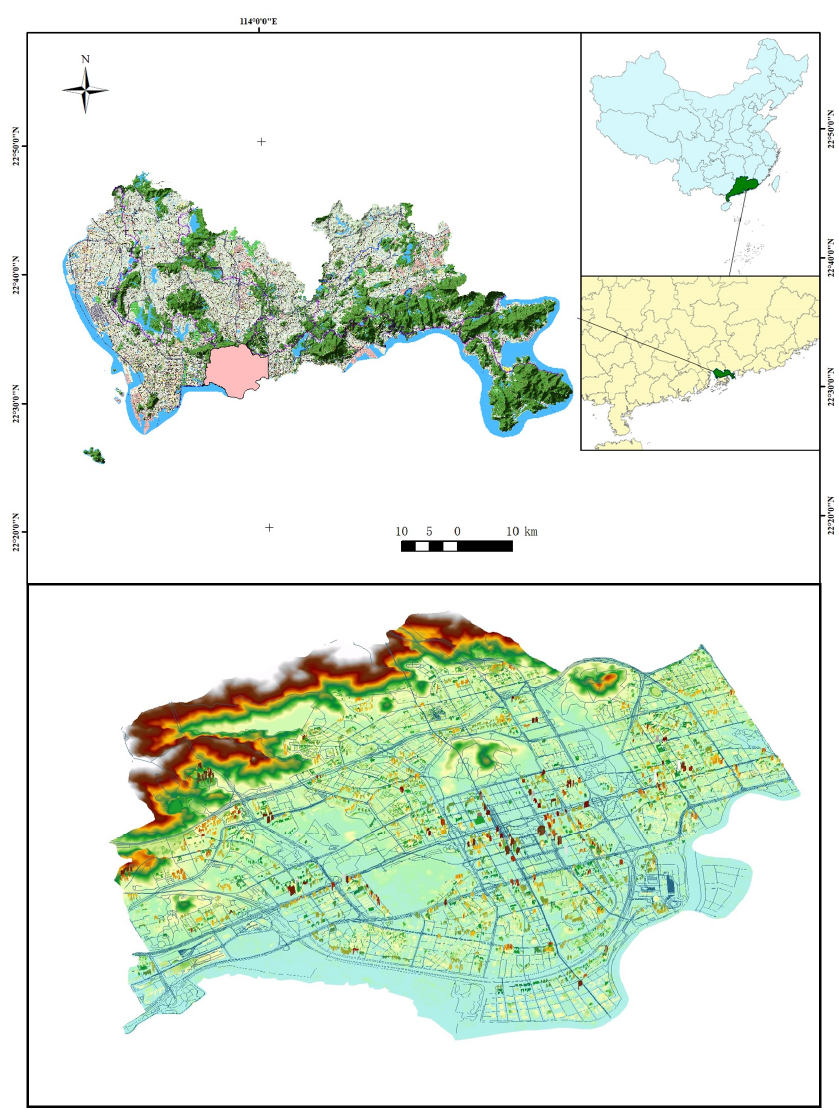
Figure 4. Futian District, Shenzhen, Guangdong Province.